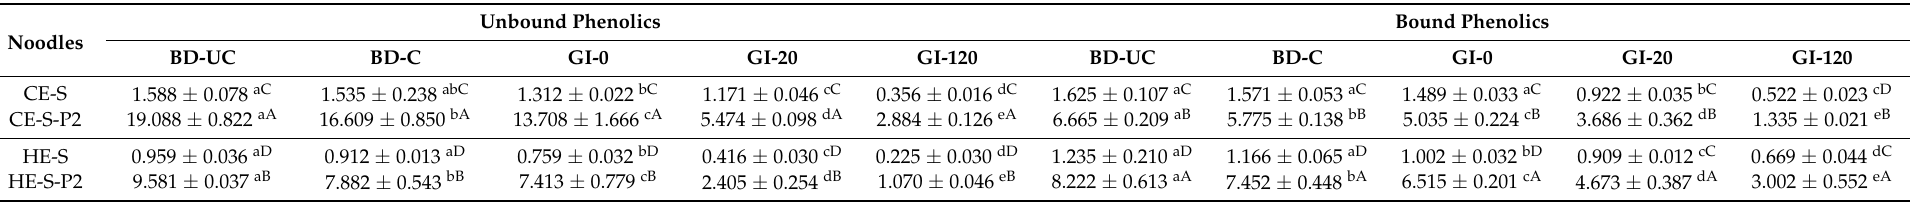
Table 3. Antioxidant activity (FRAP, µ mol Fe 2+ · g DW − 1 ) of the cold and hot extruded noodles with or without phenolics and residues during simulated in vitro gastrointestinal digestion (0, 20, and 120